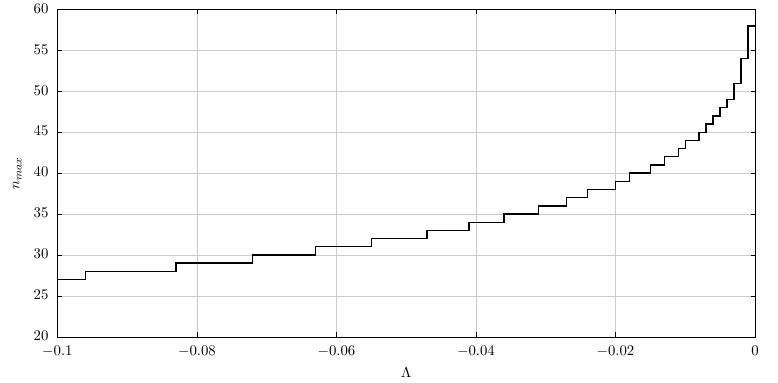
Figure 8 . The mass-radius curve for the old baby potential with (cid:21) = (cid:22) = 1 and (cid:20) 2 = 0 : 1, for di(cid:11)erent (cid:3).